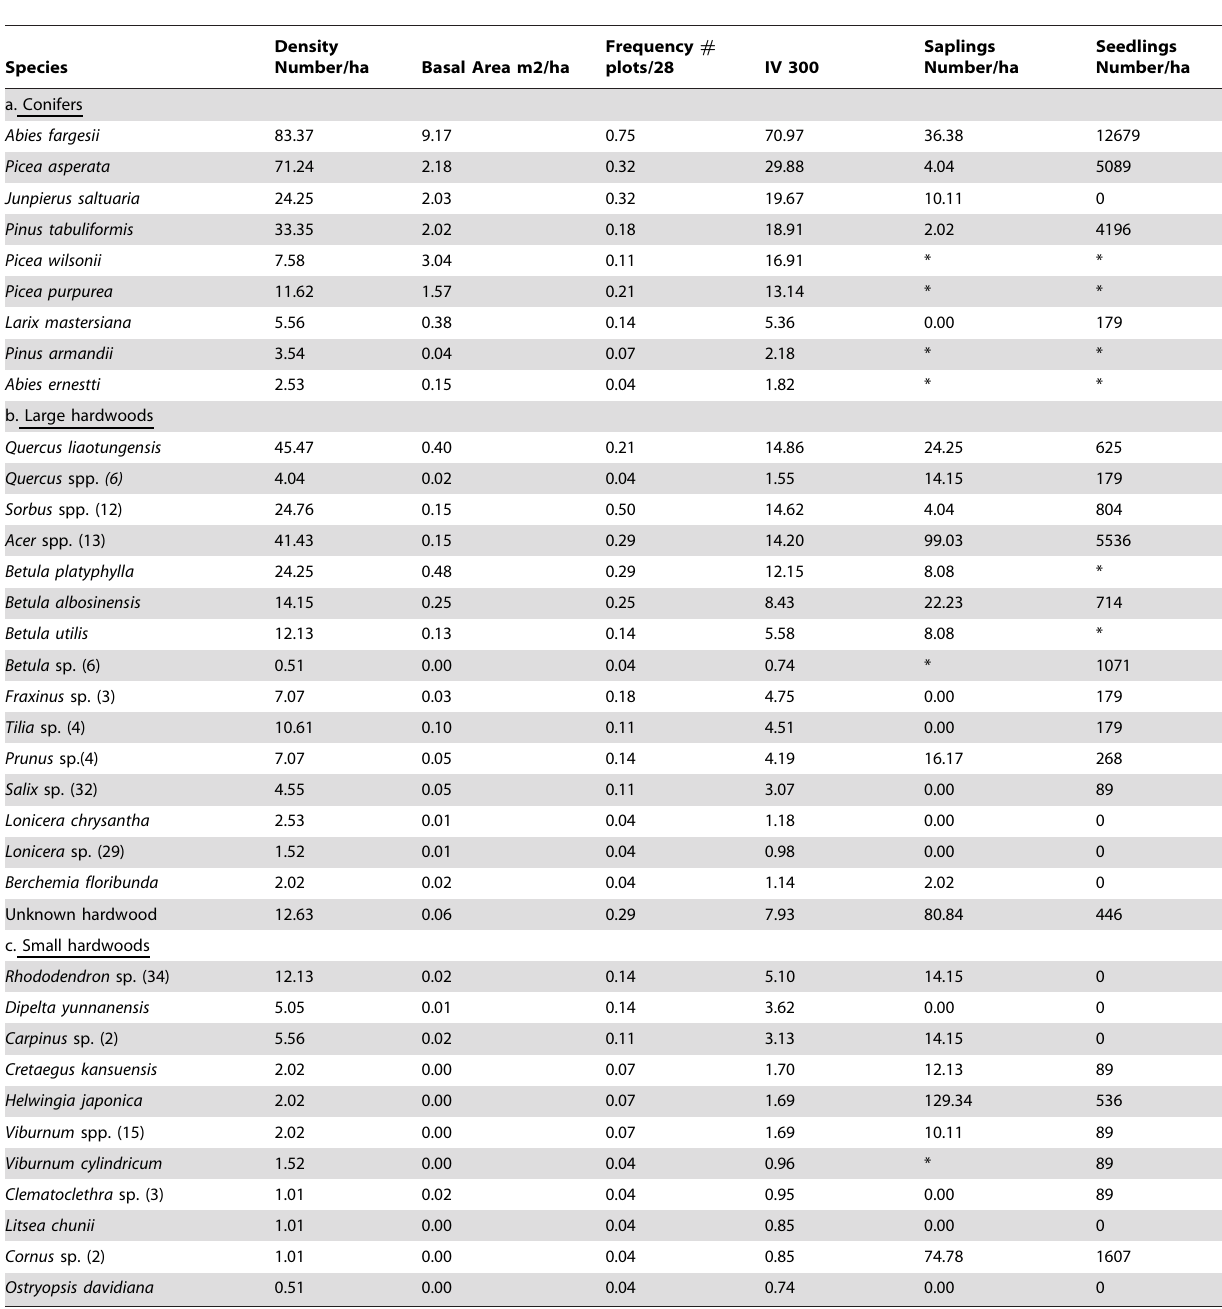
Table 1. All woody taxa exceeding 2 cm dbh sampled in 28 circular 15 m radius forest plots of Jiuzhaigou National Nature Reserve (Sichuan Province,